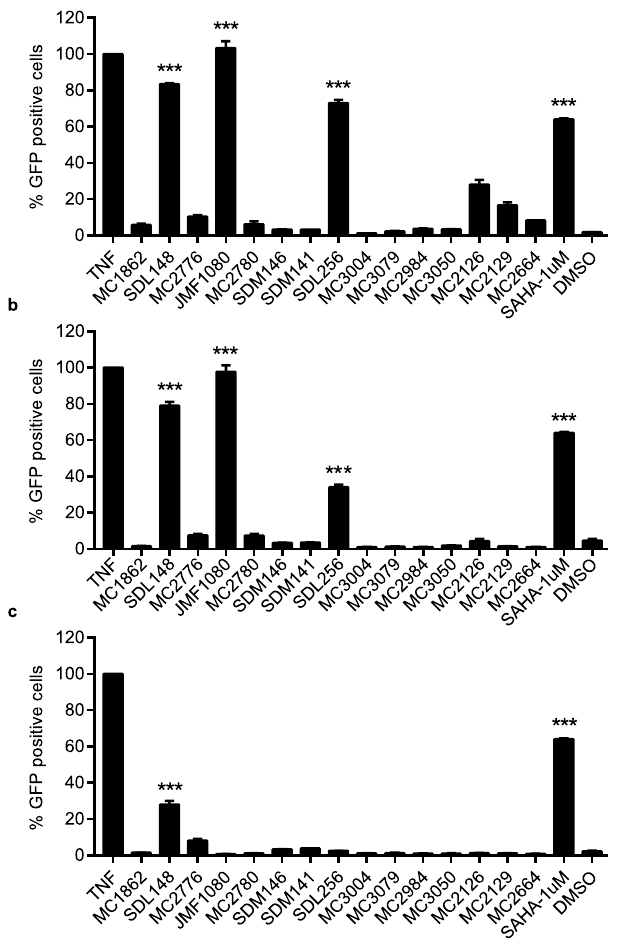
Figure 2. Screening of isoform-targeted compounds to identify HIV-1 latency reversing agents (LRAs). Identification of largazoles as potent LRAs. JLAT10.6 cells were incubated with 10 ng/mL of TNF α , 1 μ M of SAHA (vorinostat) and 10 μ M (a) , 1 μ M (b) , or 0.1 μ M (c) of screening compounds for 24 h. The percent of GFP positive cells were analyzed by FACS and the degree of HIV-1 reactivation was normalized to TNF- α . SDL148, JMF1080 and SDL256 are largazole and two analogs respectively. The mean values (mean ± s.e.m.) of a representative experiment in triplicate for each concentration is shown. *** p < 0.001